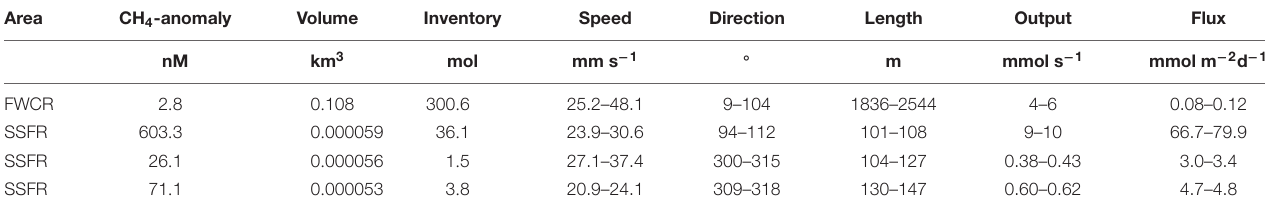
TABLE 1 | Estimation of methane flux from the seafloor at two seep sites FWCR and SSFR based on methane anomaly (equilibrium methane concentrations subtracted from measured methane concentrations) and current speed and direction.